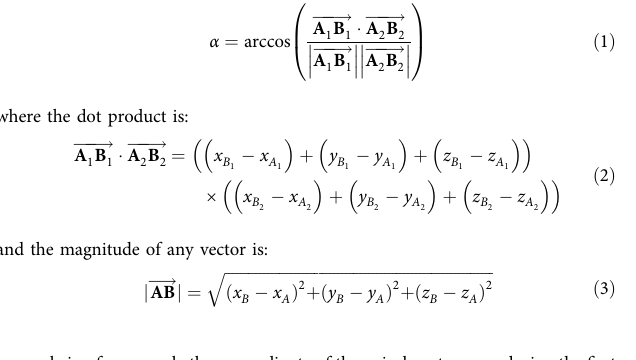
Fig. 1e: 3. Supplementary Fig. 1f: 2. Supplementary Fig. 2 GMC ablation: 10; control ablation: 7. Supplementary Fig. 3a, b: 2. Supplementary Fig. 4a: 2. Sup- plementary Fig. 4b control: 2; E-Cad RNAi: 2. Supplementary Fig. 4c control: 4; E- Cad RNAi: 3. Supplementary Fig. 4d: 2. Supplementary Fig. 4e: 1. Supplementary Fig. 4f Cindr RNAi: 1; control: 1. Supplementary Fig. 4g Flare RNAi: 2; control: 3. Supplementary Fig. 4h control: 4; Flare RNAi: 3. Supplementary Fig. 5: control